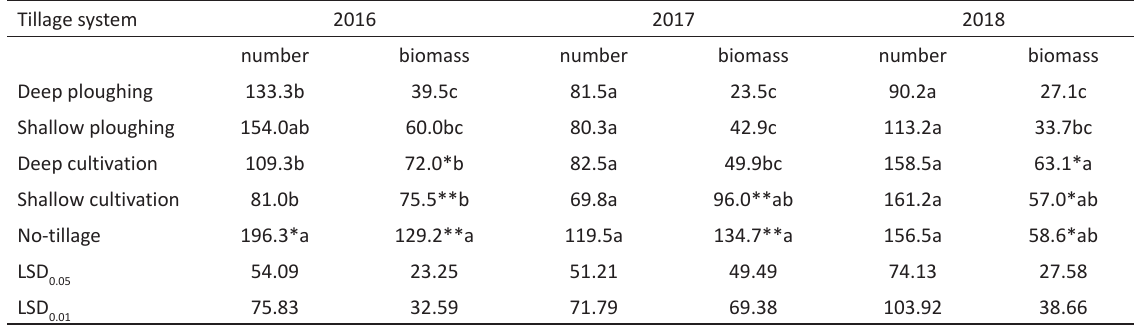
Table 7. Effect of different tillage practise on number (m -2 ) and fresh biomass (g m -2 ) of earthworms Tillage system Deep ploughing